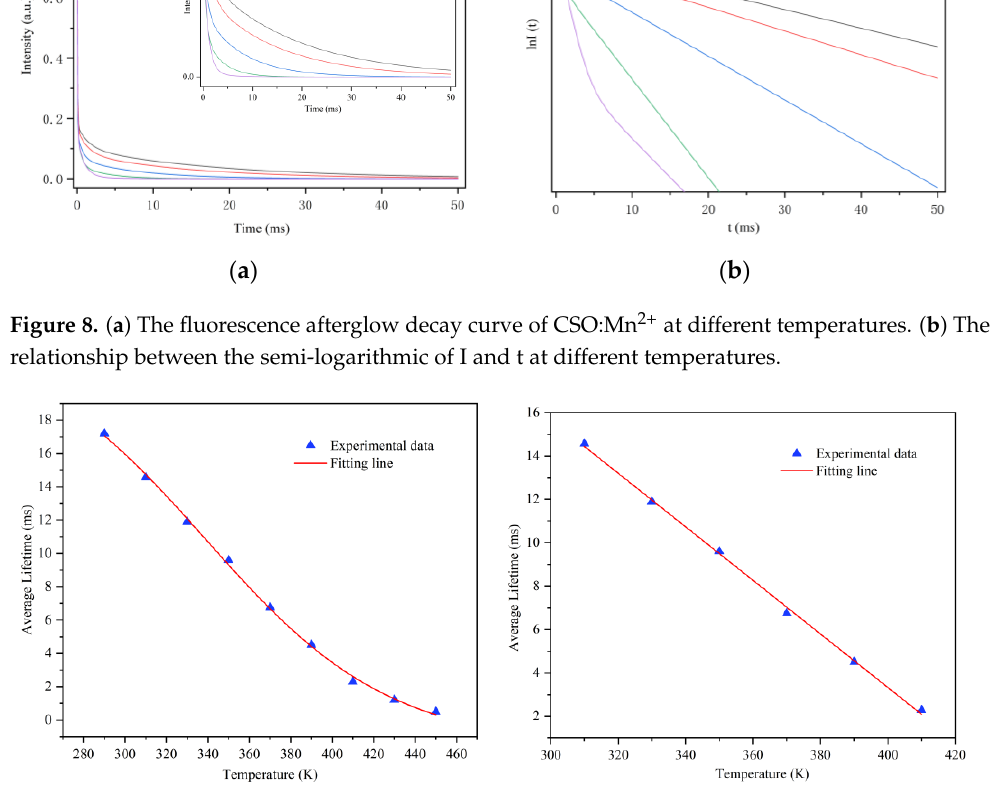
Figure 8. ( a ) The fluorescence afterglow decay curve of CSO:Mn 2+ at different temperatures. ( b ) The relationship between the semi-logarithmic of I and t at different temperatures.